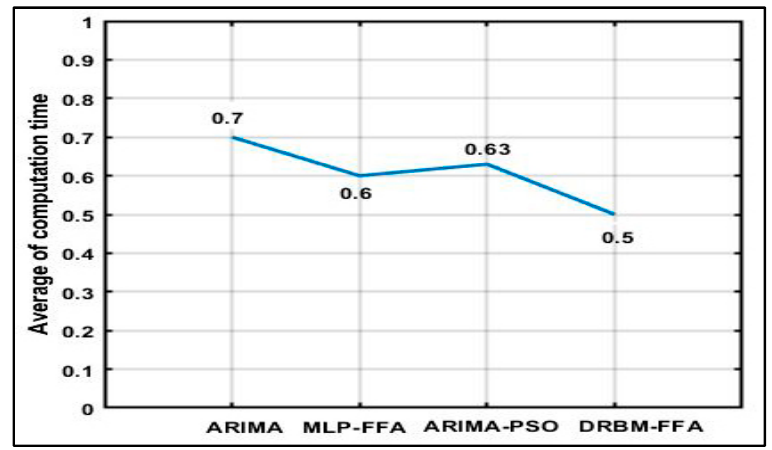
Figure 9. Average of computation time.